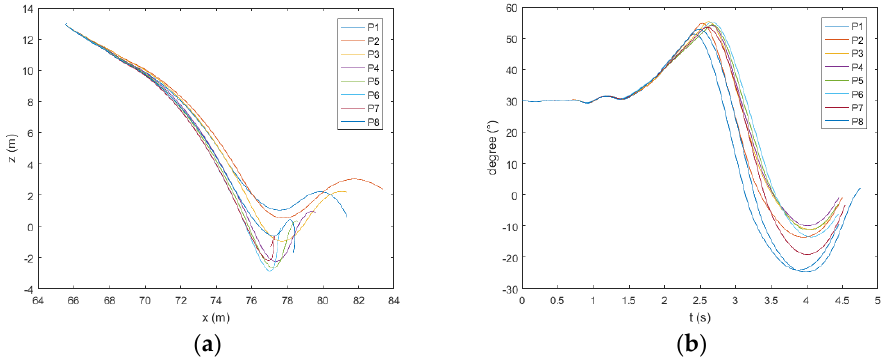
Figure 16. Trajectory ( a ) and pitch ( b ) of the lifeboat freefall when the wave height is 4 m.